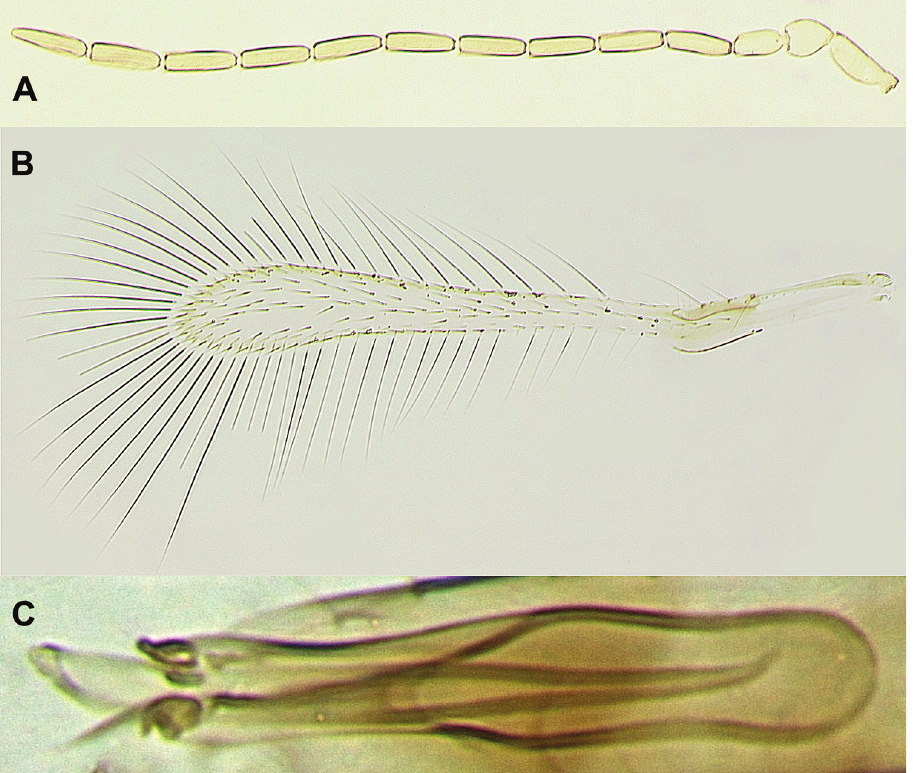
Figure 3. Anagrus dmitrievi (male, paratypes): A antenna B fore wing C genitalia. Male (paratypes). Body length of the dry-mounted, critical point-dried